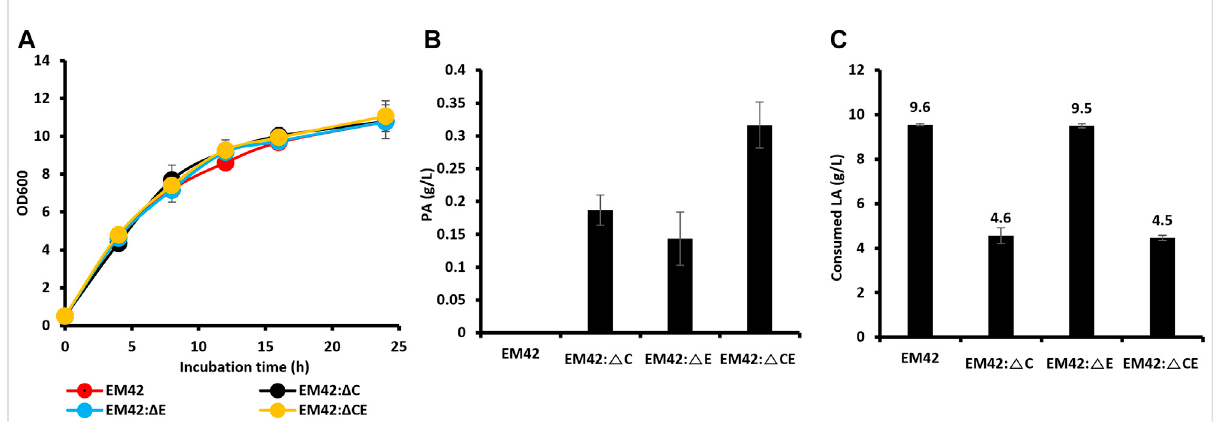
FIGURE 1 Thegrowthpattern (A) ,PAproduction (B) ,andconcentrationofresidualLA (C) bywildtype(EM42)andotherstrainswithdeleted prpC and prpE . The presented value is the mean value of three experiments. The standard deviation is represented by error